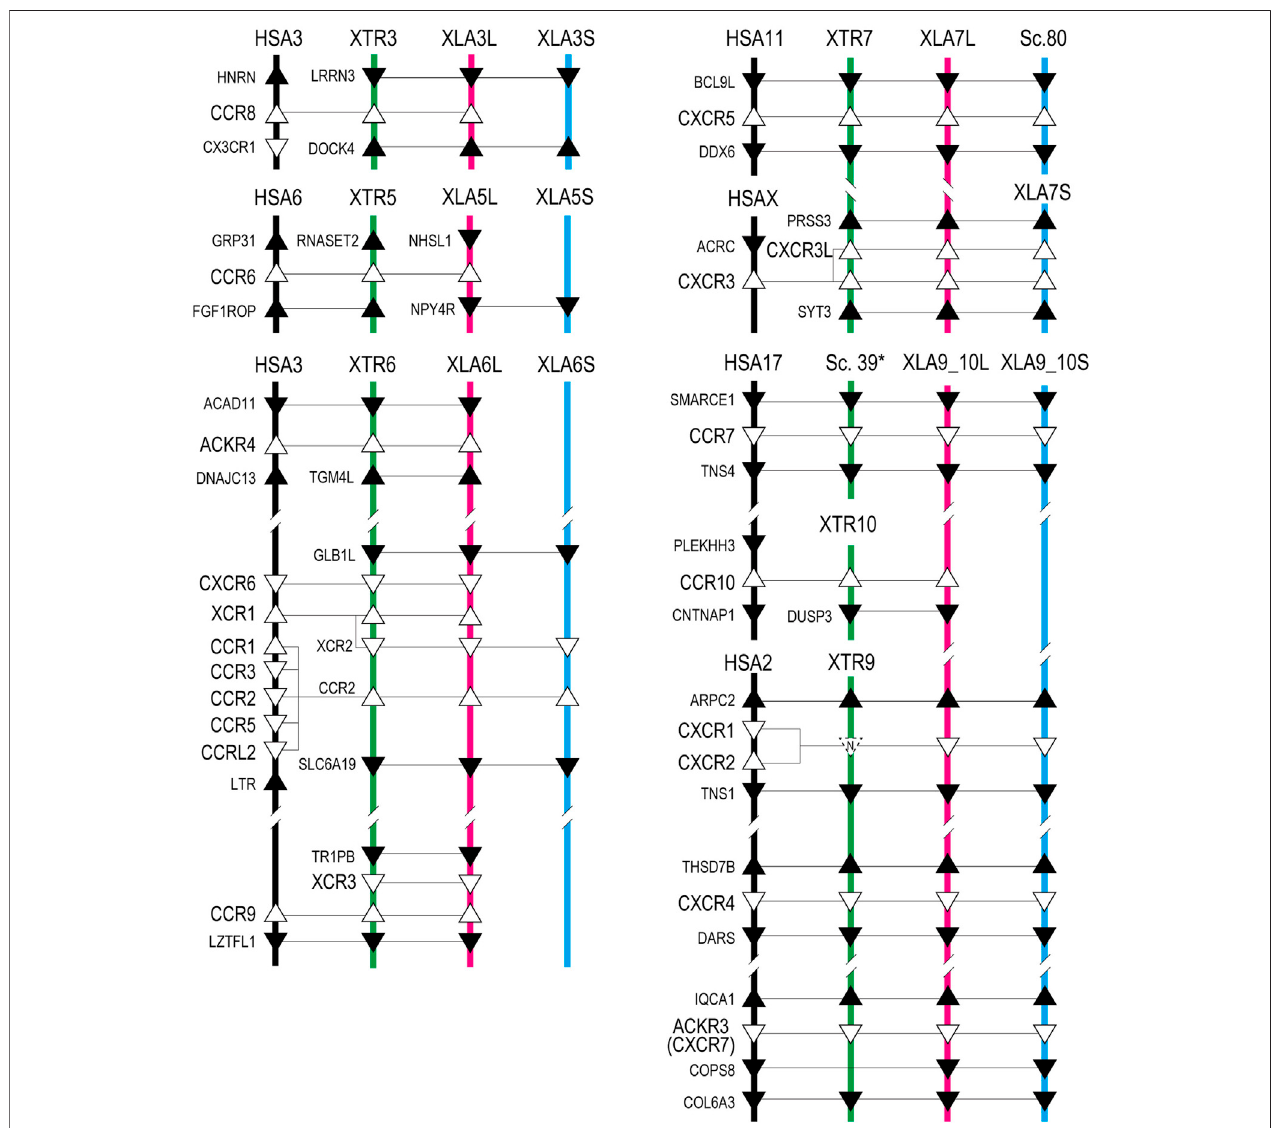
FIGURE 2 | Genomic organization of Xenopus chemokine receptors. Representation is the same as Figure 1 .